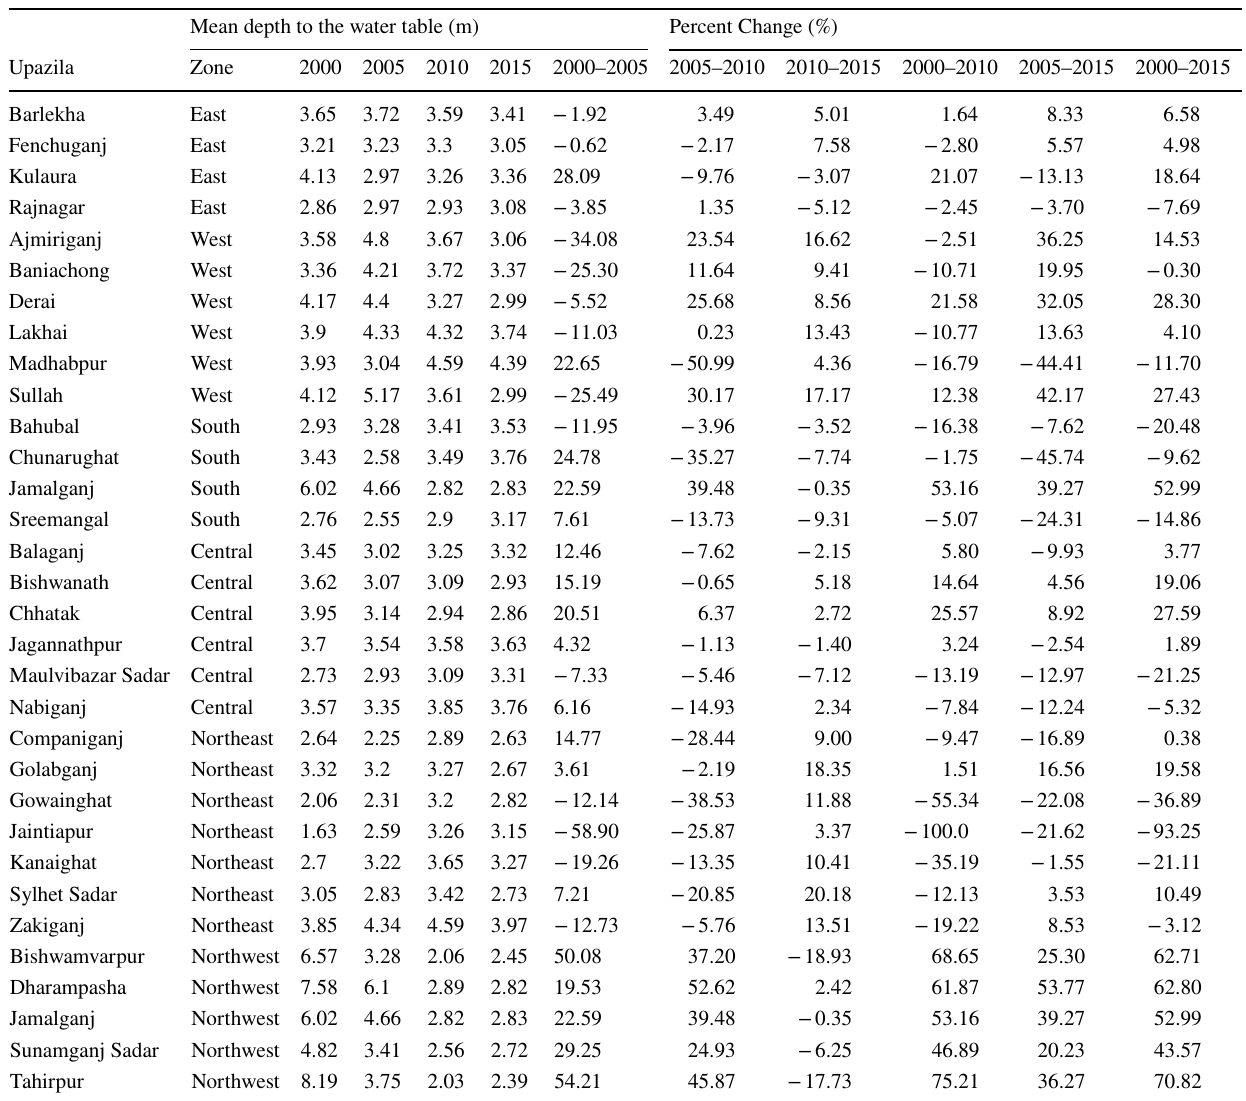
Table 3 The table shows the mean annual groundwater levels and indicates a lowering (a water table is deeper from the ground). Besides, it lists the corresponding zones of the studied Upazilas their temporal percent change by Upazila under the study area. A defined in this work positive percent change indicates a decrease in depth to water table (a water table is closer to the ground) while a negative percent change Mean depth to the water table (m) Percent Change